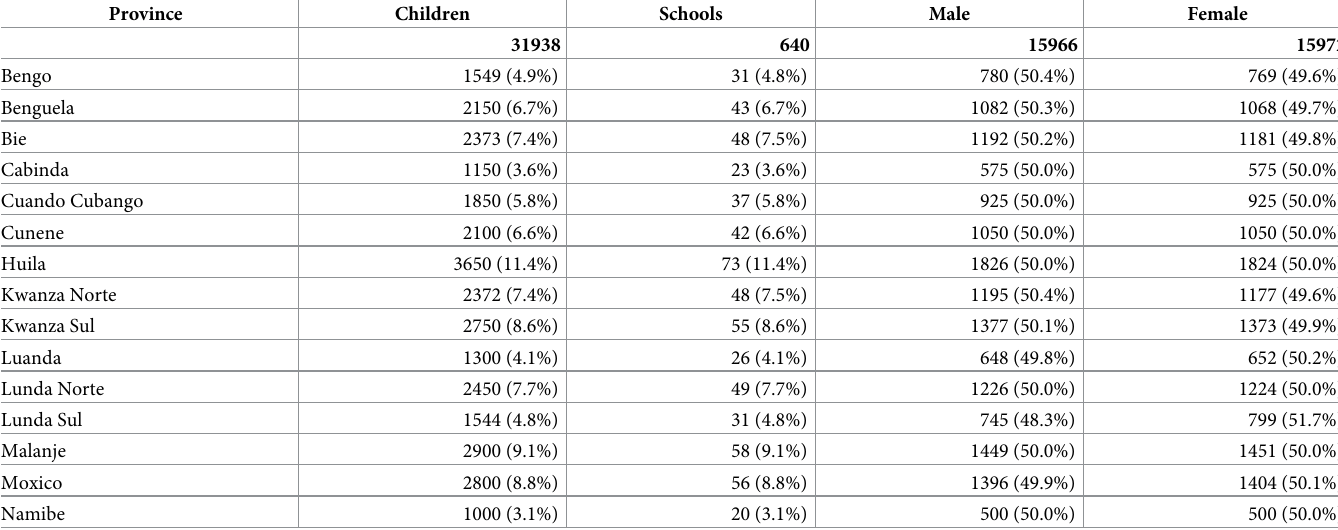
Table 1. Geographical Distribution of sampled schools and children and key characteristics of the